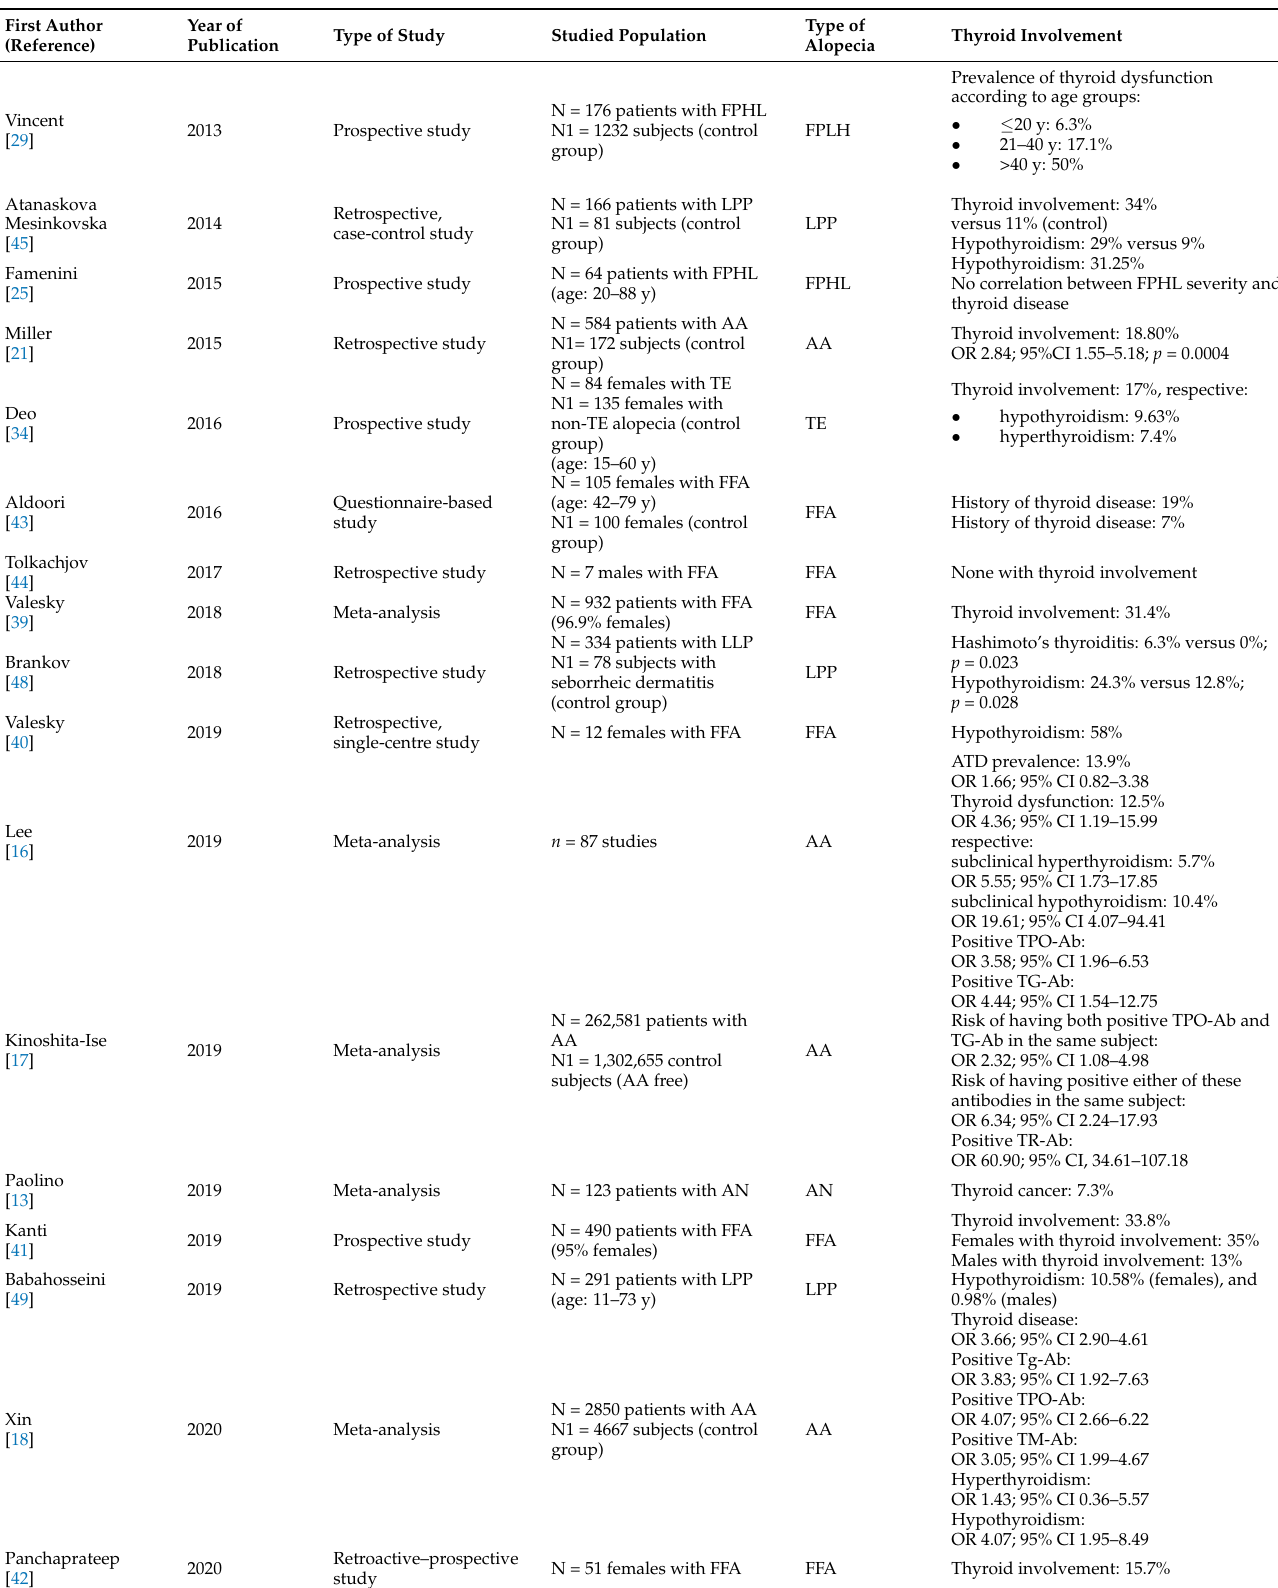
Table 1. introduces the most clinically relevant study from a dermatologic perspective of alopecia and thyroid findings. The articles are displayed starting with 2013 (please see references [13,16–